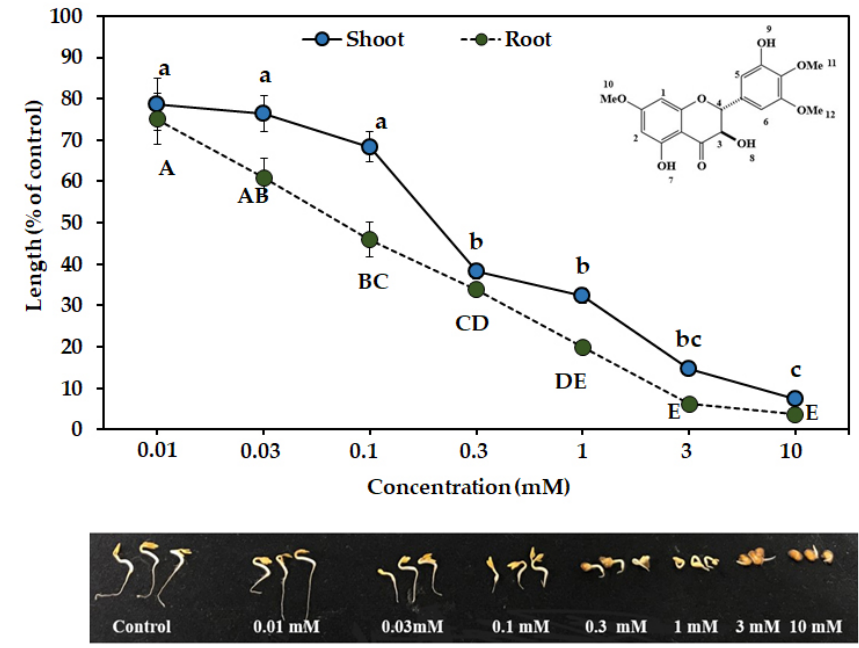
Figure 5. The effect of compound 2 (7,4′,5′ -tri- O -methylampelopsin) on the shoot and root growth of the cress seedling. Data are shown as means ± standard errors. Different letters indicate significant differences between treatments for shoots (small letters) and roots (capital letters) (Tukey’s HSD, p ≤ 0.05). Table 2. EC 50 values of 7,4′,5′ -tri- O - methyl dihydroquercetin and 7,4′,5′ -tri- O -methylampelopsin for the growth of cress seedlings.